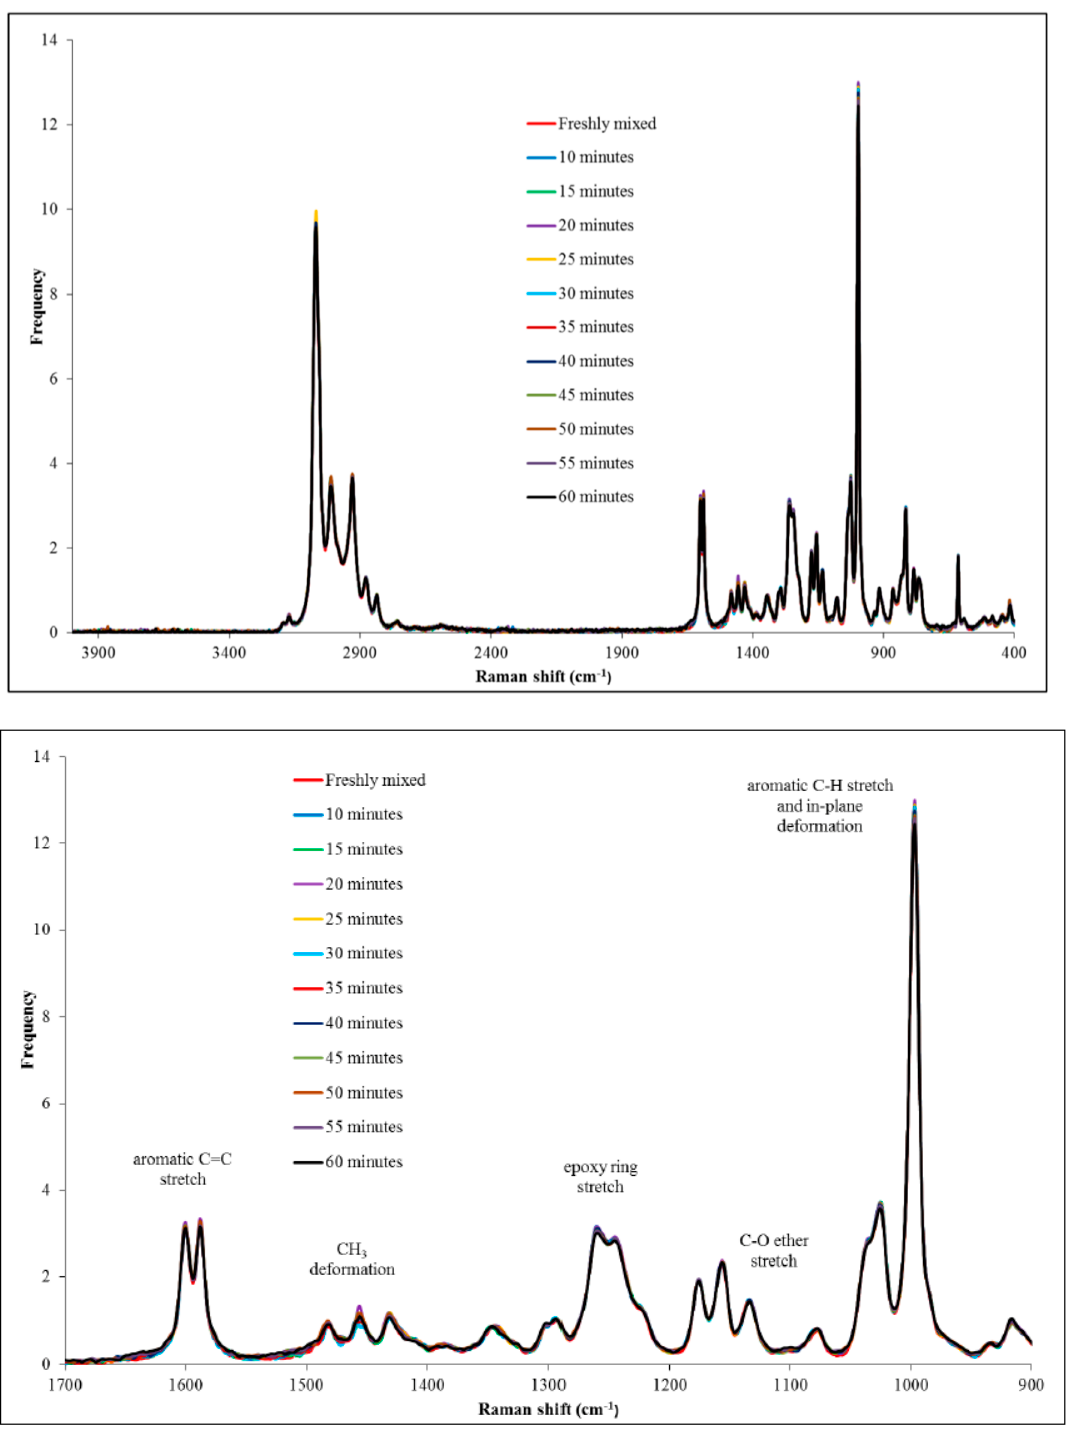
Figure 4. Raman spectra for a room-temperature-stored formulation comprising of PGE (5 g) and 1-ethyl-3-methylimidazolium acetate (0.25 g) as a function of time ( top: full spectrum and bottom: expansion).